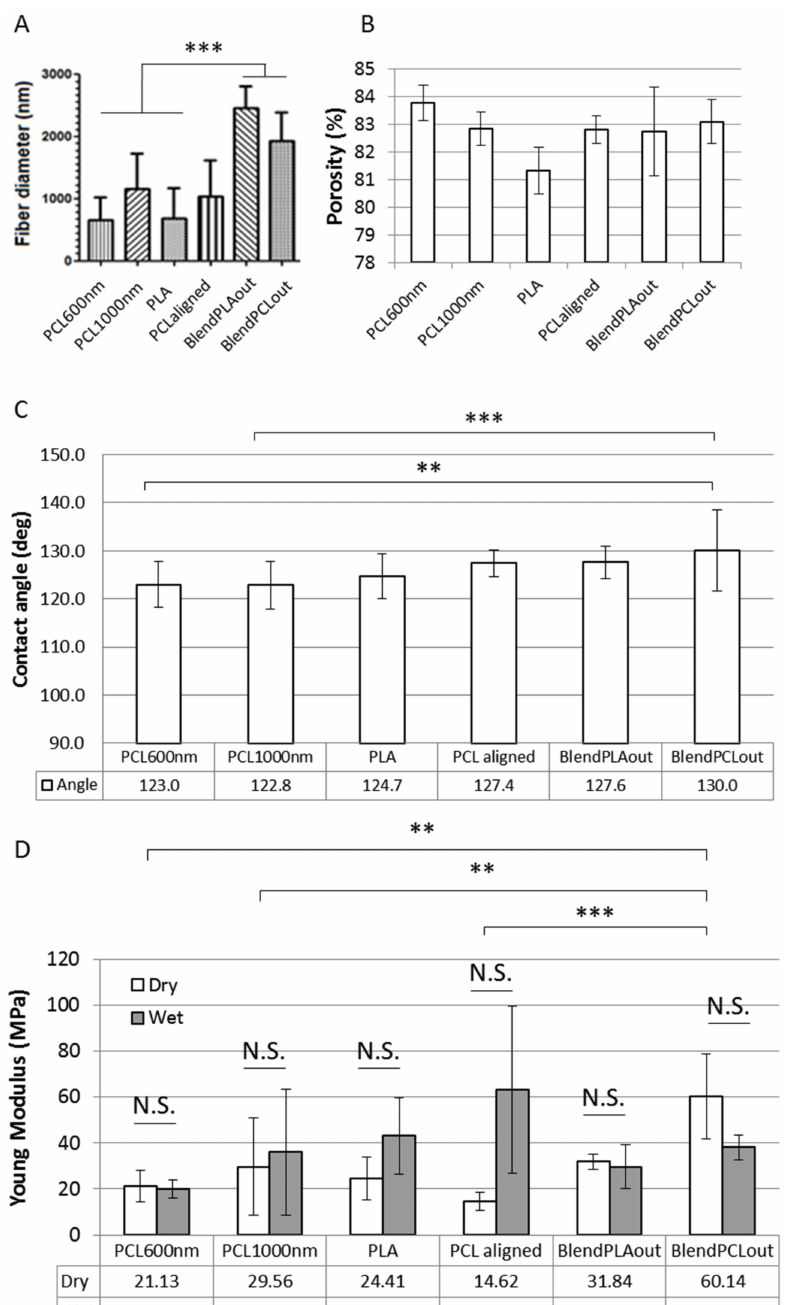
Figure 3. Morphological and mechanical characterization of the different scaffolds. ( A ) Fiber diameters of the electrospun scaffolds; ( B ) Estimation of scaffold porosity using image processing for the electrospun scaffolds. The µ + δ threshold focuses on the porosity of the upper layers of fibers; ( C ) contact angle measured on each electrospun scaffold; ( D ) Young’s moduli of each scaffold. Comparisons of Young’s moduli were made between dry and wet samples, and between scaffolds based on dry samples. N.S., non-significant, ** p < 0.01, *** p <